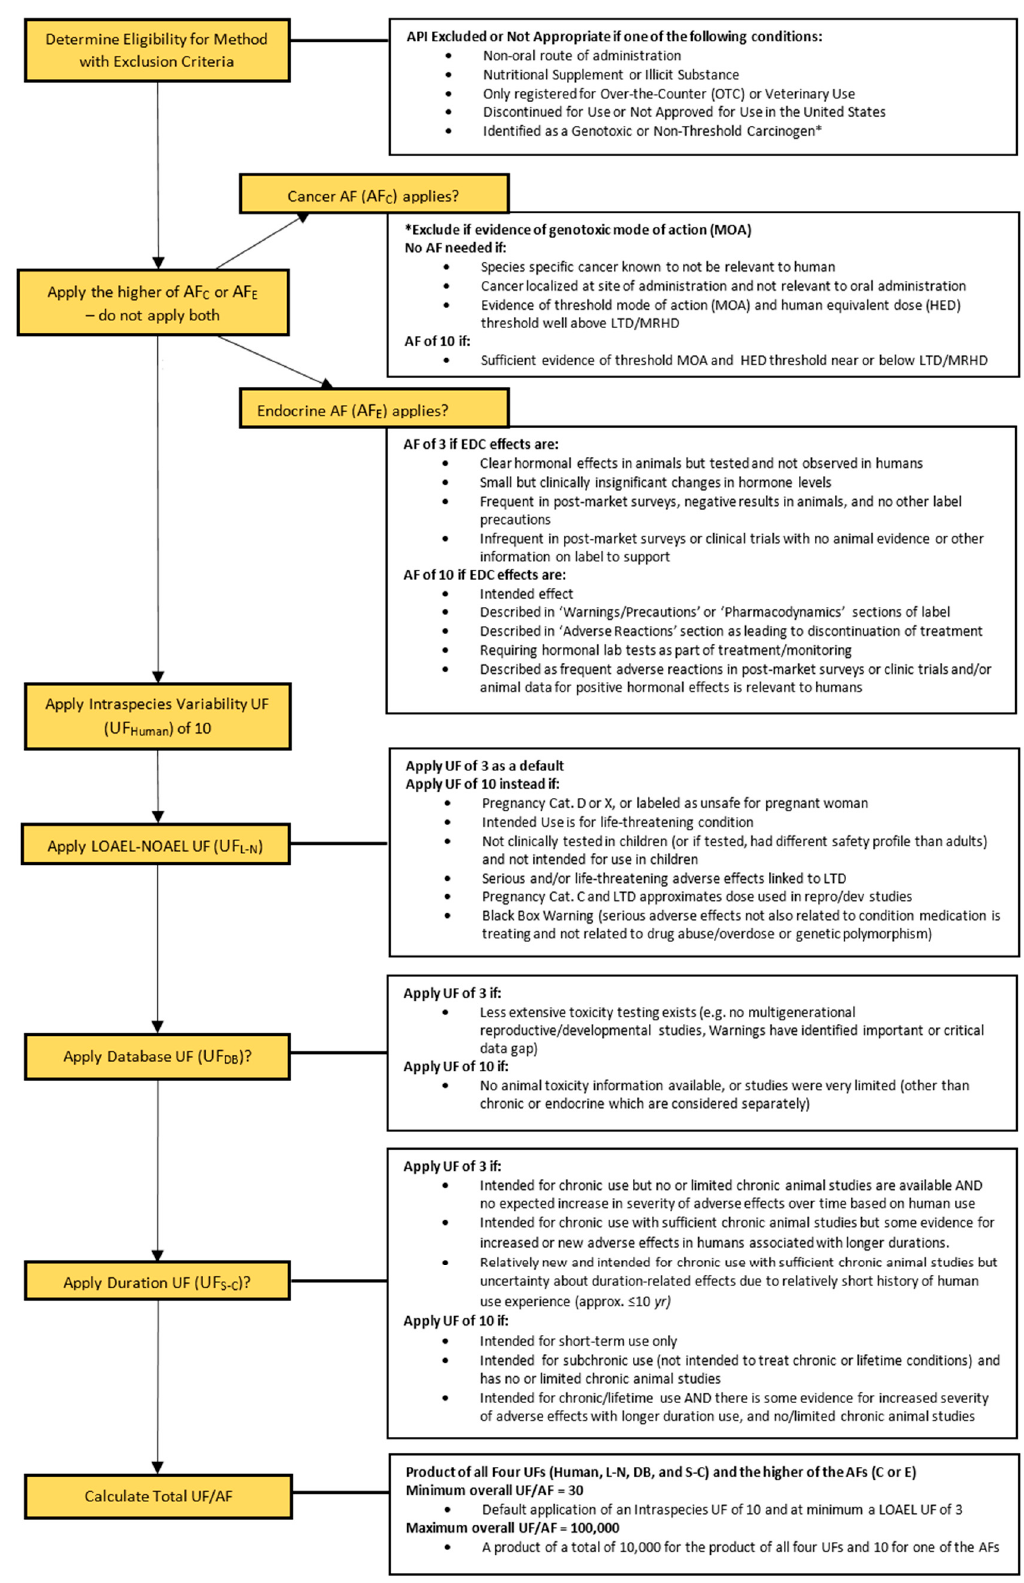
Figure 1. The decision tree provides a summary and guide for the decisions made in regards to application of Adjustment Factors (AFs), Uncertainty Factors (UFs), and calculation of Total UF/AF for use in derivation of a screening reference dose (sRfD).